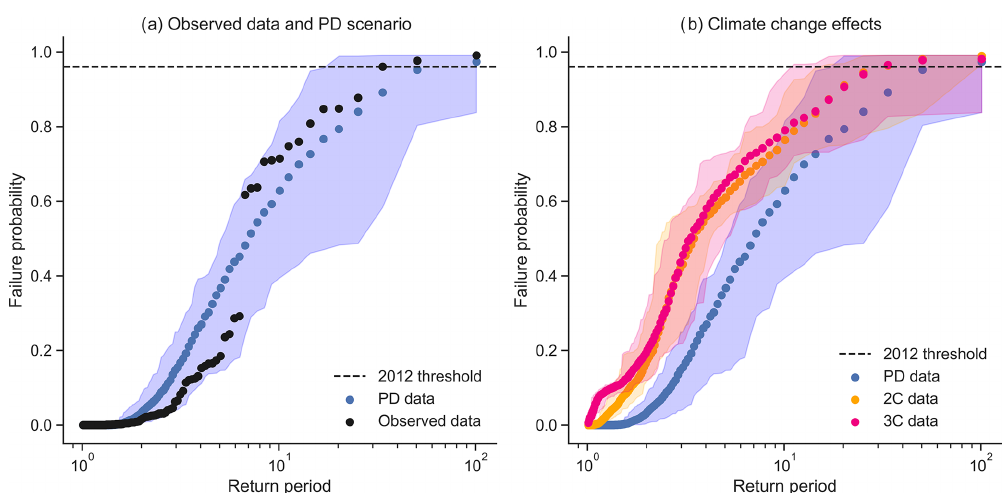
Figure 5. (a) Random forest model failure probabilities for different return periods, comparing observed data (black) to the PD scenario (blue). (b) Return periods for PD (blue), 2C (orange) and 3C (pink). Dots show the 20-member mean; shading shows the range across the 20 members. The dashed line represents the failure probability of the 2012 season predicted by the RF model (Sect. 3.4).